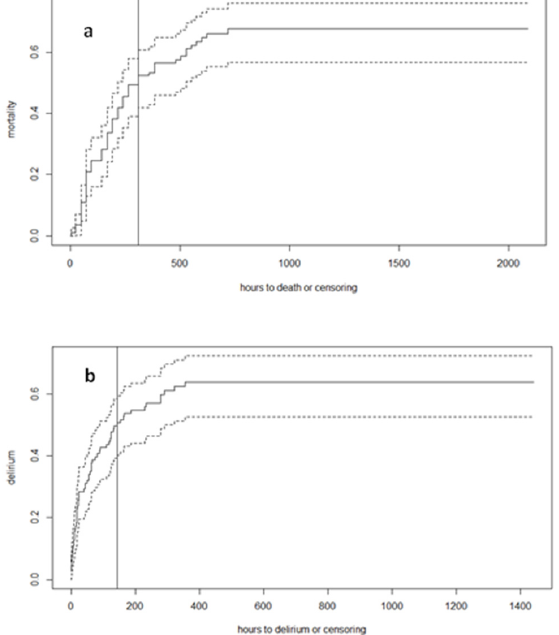
Figure 1. Time course of mortality and delirium onset. Panel ( a ). Time course of mortality (continuous line) and 95% CI (dotted lines). Panel ( b ) Time course of delirium onset (continuous line) and 95% CI (dotted lines). Full vertical lines represent the time point when 50% of mortality/delirium were reached.